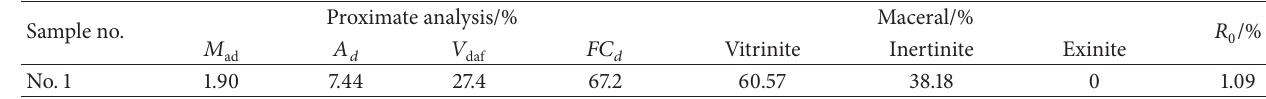
Table 1: Properties of coal sample.